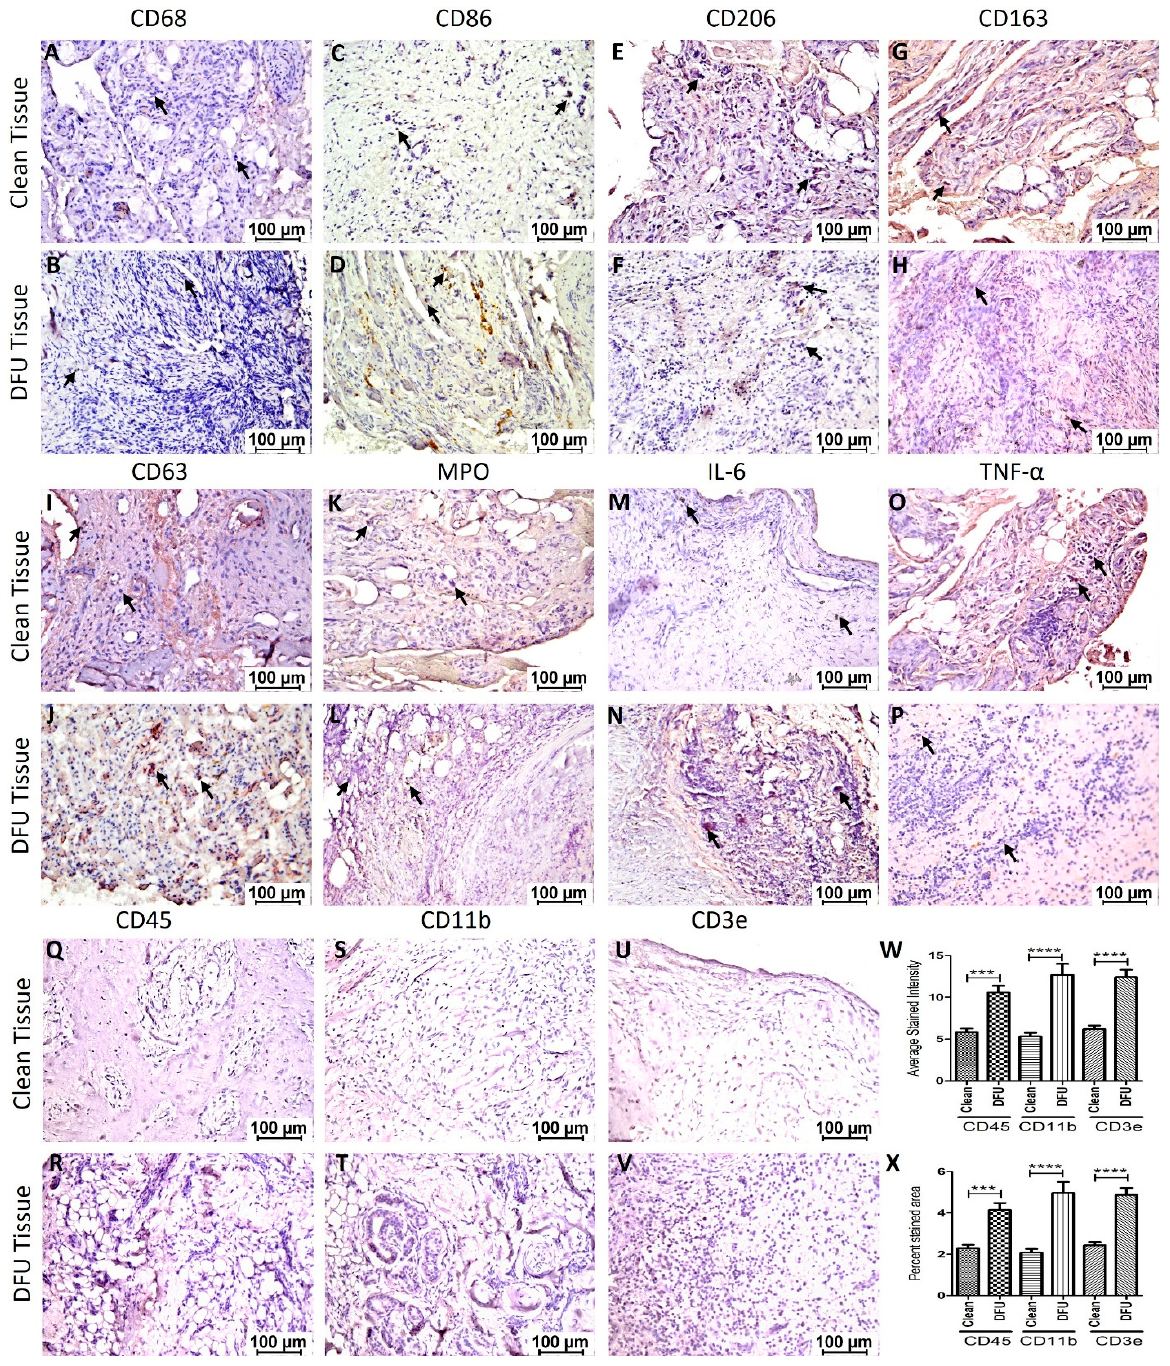
Figure 4. Immunostaining for mediators of inflammation and immune cell markers in clean and diabetic foot ulcer (DFU) samples. Macrophages (CD68, A , B ), pro-inflammatory macrophages (M1 macrophage, CD86- C , D ), anti-inflammatory macrophages (M2a macrophages, CD206- E , F ; and M2b macrophages, CD163, G , H ), activated neutrophils (CD63, I , J ), neutrophils (myeloperoxidase-MPO- K , L ), and pro-inflammatory cytokines IL-6 ( M , N ), TNF- α ( O , P ), CD45 ( Q , R ), CD11b ( S , T ), CD3e ( U , V ), and average stained intensity ( W ), and percent stained area ( X ). The images are representative images for both clean and DFU samples. The arrow shows stained cells in each panel. The data are presented as mean ± SD ( n = 11 in each group). *** p < 0.001 and **** p <